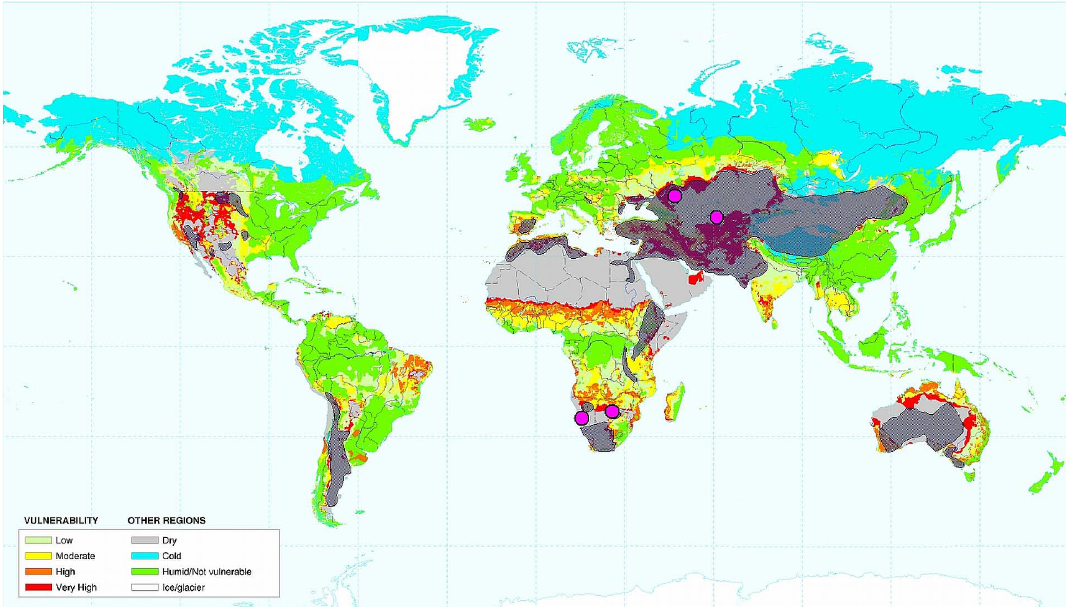
Fig. 1. Backdrop image: global desertification vulnerability (USDA-NRCS, Soil Survey Division, World Soil Resources, Washington D.C. 1996). Gray shading: global distribution of recent salt lakes and salt soils (after Williams, 2002). Pink dots indicate the study ar- eas mentioned in this study: Aralkum desert in Central Asia, Kalmykia in southern Russia, coastal wetlands of Namibia, and inland salt flats of Botswana.